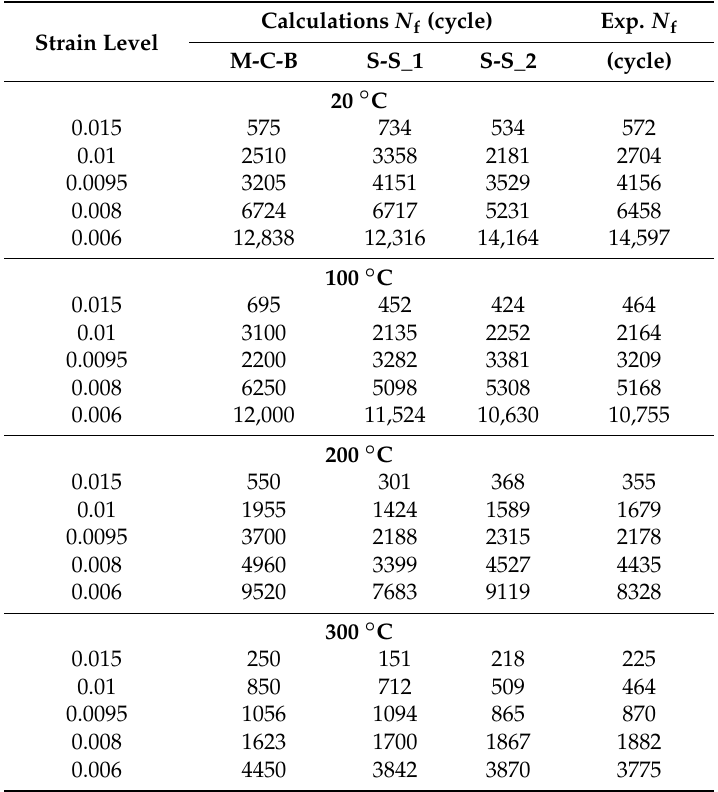
Table 5. Experimental data and results of numerical simulations of fatigue damage accumulation for uniaxial loads at elevated